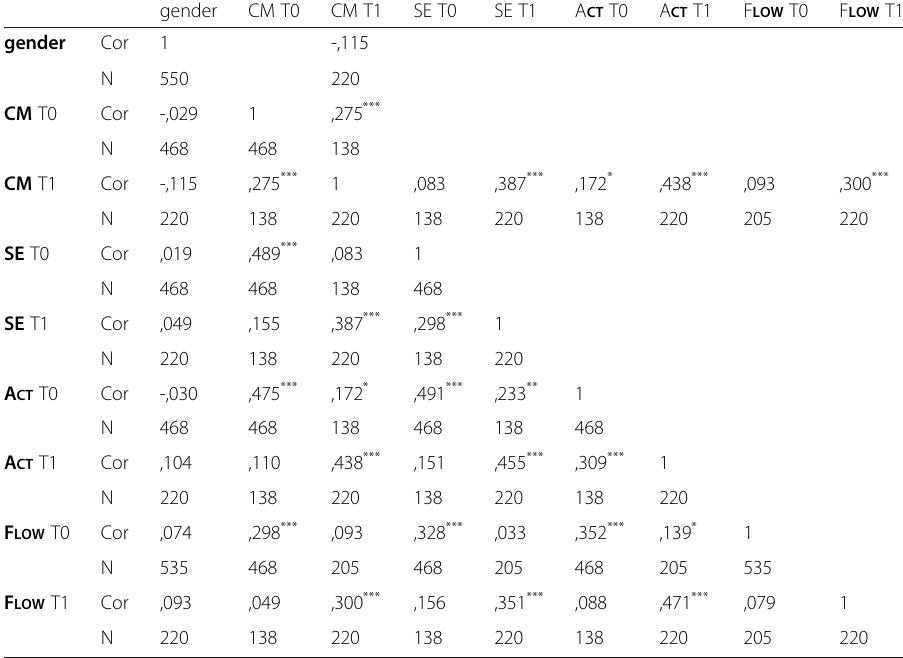
Table 6 Bivariate correlations of the variables (pearson) N ≥